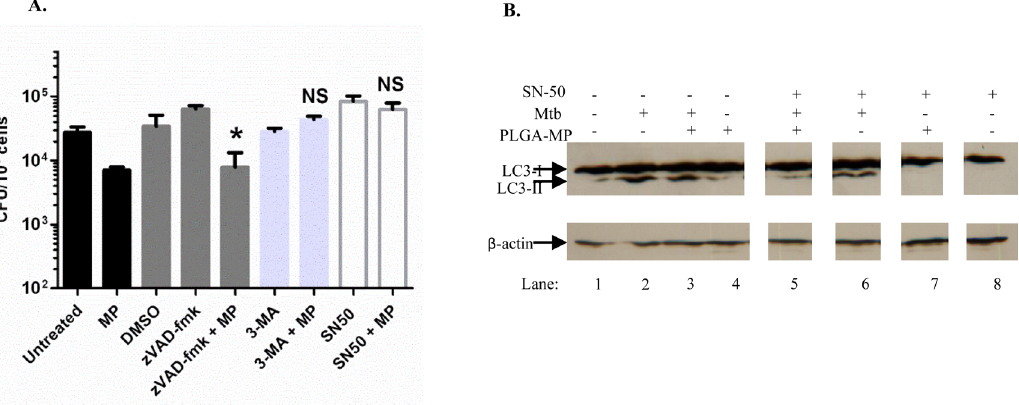
Fig 7. Blocking autophagy or NFkB activity interferes with killing of Mtb in PLGA PLGA MP-treated macrophages. (A) PMA-differentiated THP-1 cells were untreated or pre-incubated with inhibitors (50 μ M zVAD.fmk, 10mM 3-MA or 10 μ M SN50) vehicle (DMSO) for 1 hour and then infected for 3 hours with H37Ra at an MOI of 1 – 5 phagocytosed bacilli per cell. Extracellular mycobacteria were washed and the cells were incubated with 2.2 μ m PLGA MPs (200 μ g/ ml) for 1 hour followed by washing to remove extracellular MPs. The cells were then incubated for a total of 72 hours after which CFU were determined by serial dilution on Middlebrook agar plates. * p < 0.05 compared to untreated (for MPs) or DMSO (for zVAD-fmk). NS = not significant compared to untreated cells. (B) Induction of LC3-II in macrophages infected with H37Ra Mtb. Macrophages were infected with Mtb for 3 hours and treated with PLGA MP in the presence or absence of SN50 for a further 3 hours. Whole-cell lysates were subjected to SDS-PAGE, followed by western blot analysis using the indicated